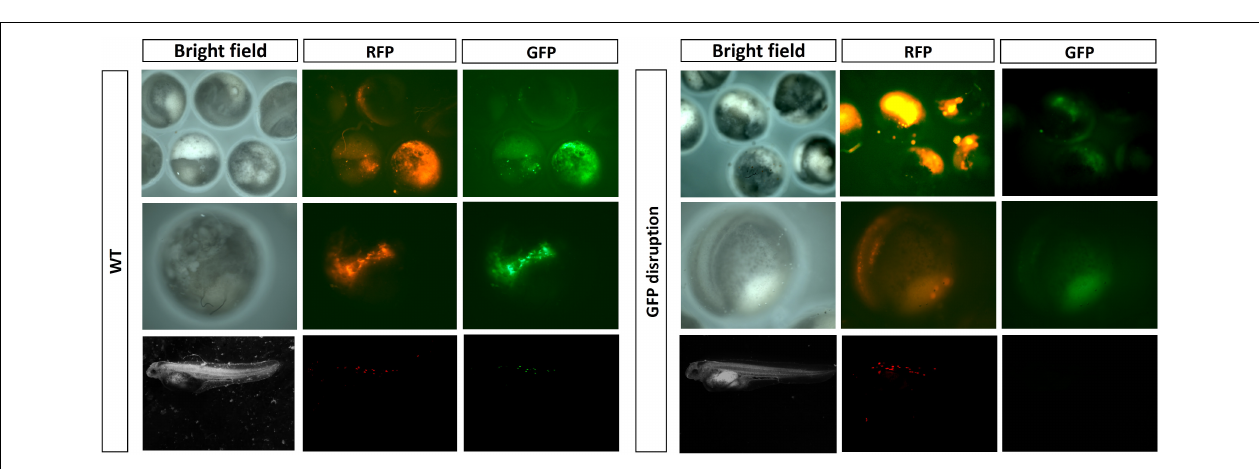
FIGURE 4 | Disruption of EGFP by CRISPR/Cas9 in sterlet. A total of 682 embryos were injected with Cas9 mRNA, and 625 were injected with Cas9 nuclease. (A) Induced by Cas9 mRNA. (B) Induced by Cas9 nuclease. (C) Survival rate of injected embryos. (D) Mutation rate at target site. The survival rate and mutaion rate were transformed to arcsine square root, then analyzed by ANOVA followed by Student–Newman–Keuls method. Symbols with the same indicate groups that are not significantly different.